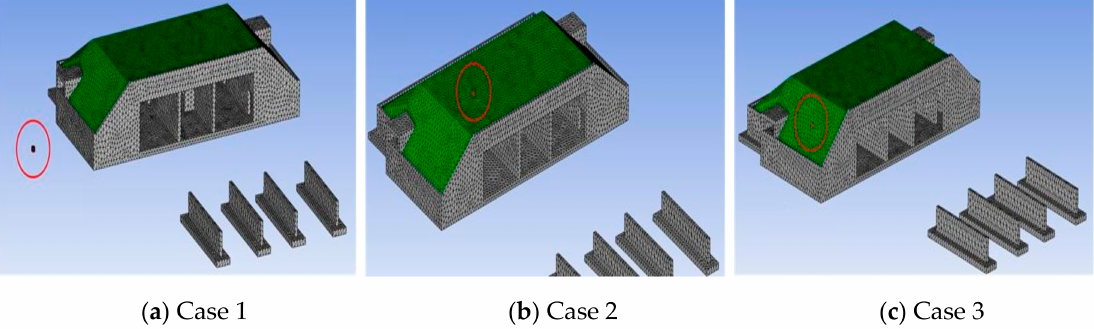
Figure 8. Basting load